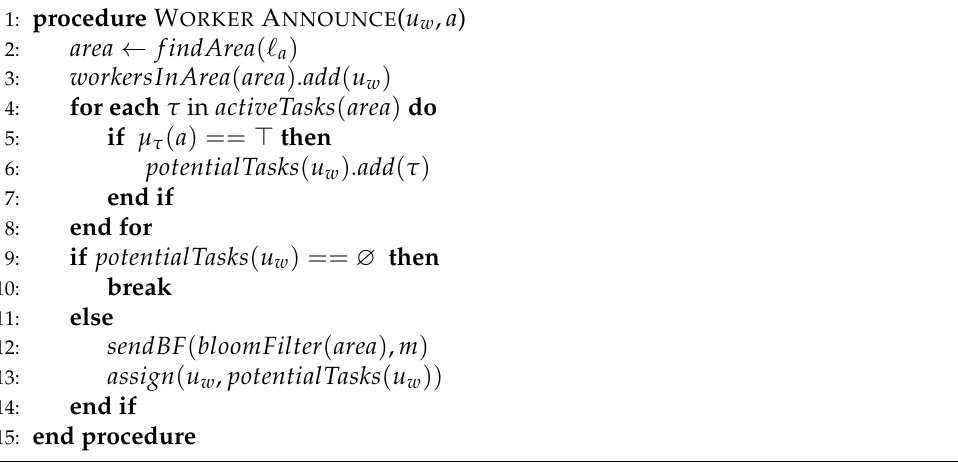
Algorithm 1 Arrival of a new worker in the area covered by the ME host